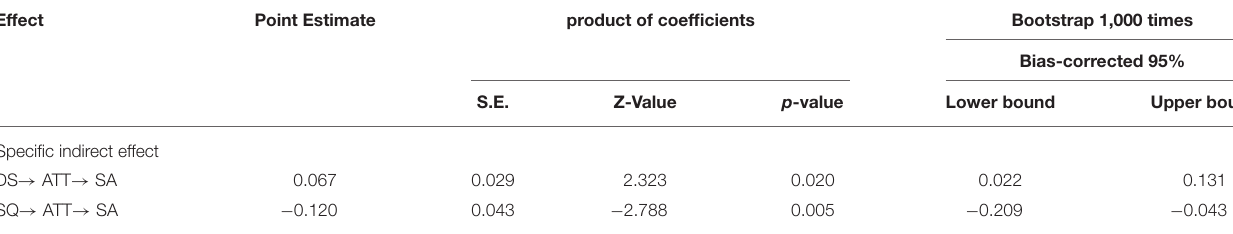
TABLE 8 | The analysis of indirect